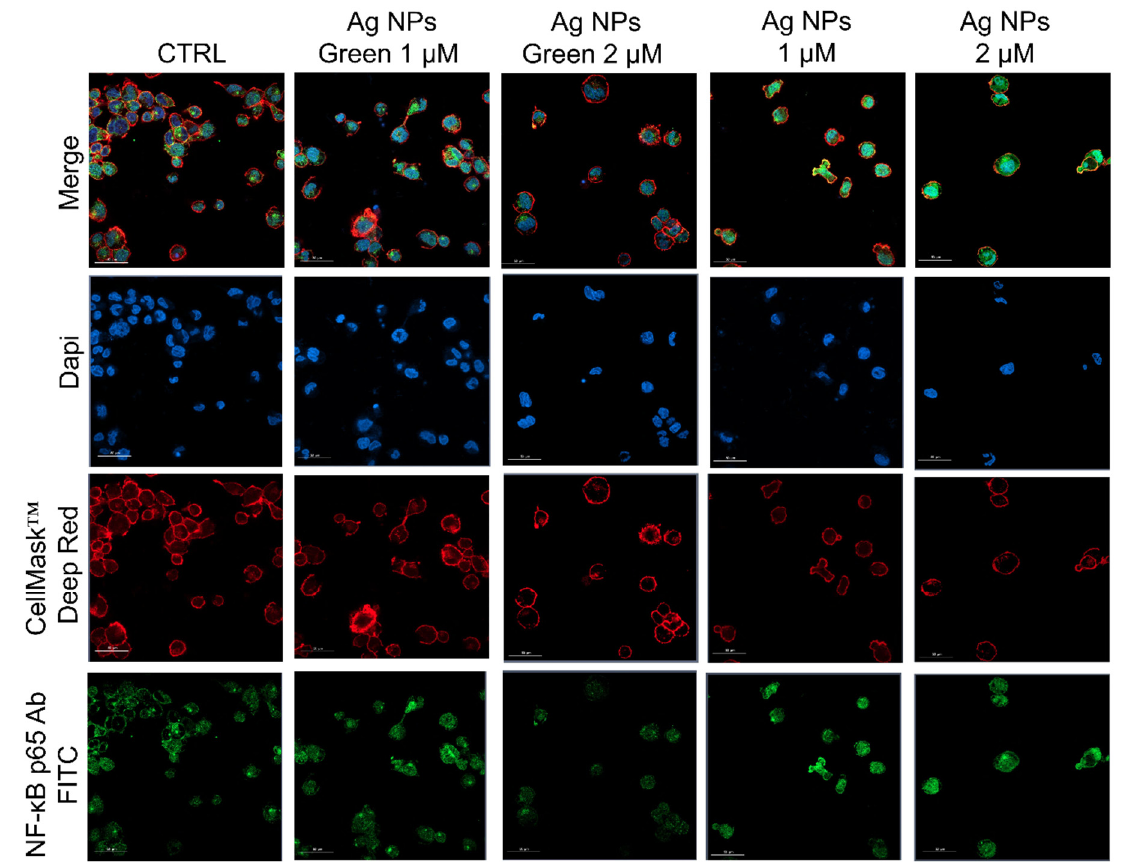
Figure 5. Representative confocal images of untreated macrophages (M0, control) and macrophages exposed to the 1 µM and 2 µM of green Ag NPs and conventional Ag NPs for 24 h. The cells were fixed and then stained. The nuclei were labeled with DAPI (blue), Actin cytoskeleton with Cell- Mask™ (red), and NF- κ B with NF- κ B p65 Antibody (F-6) FITC (green intensity signal). Scale bar is 50 µm.